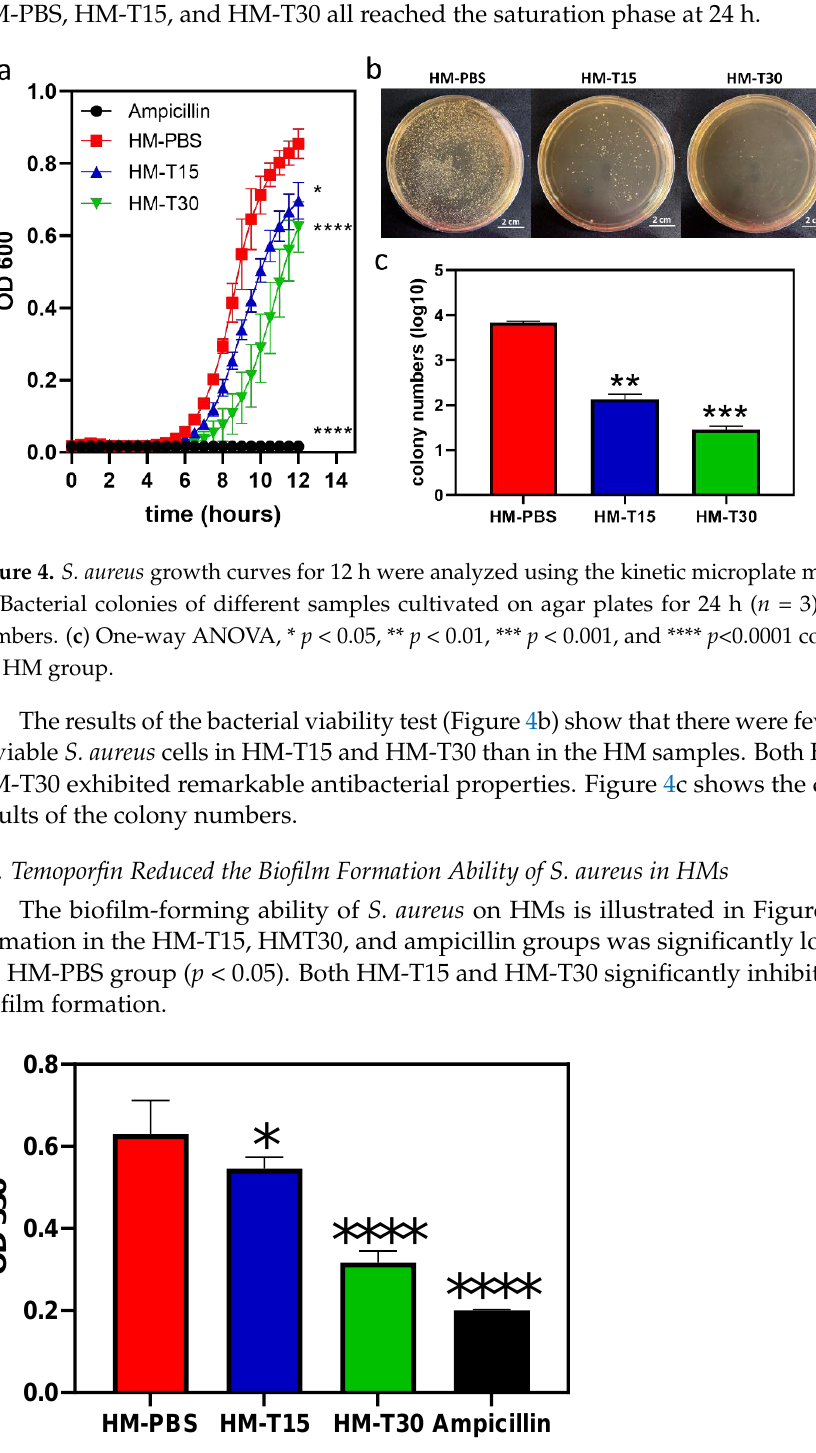
Figure 5. Biofilm-forming ability of S. aureus ( n = 6,). One-way ANOVA, * p < 0.05, and **** p < 0.0001 compared with the HM group.